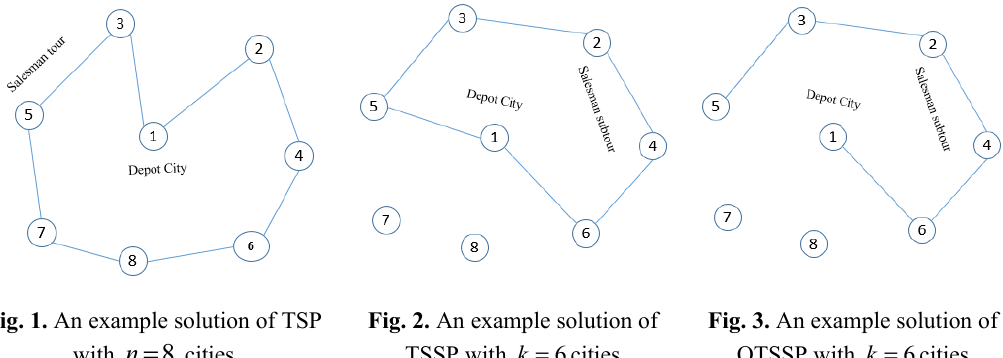
Fig. 1. An example solution of TSP with 8 n = cities